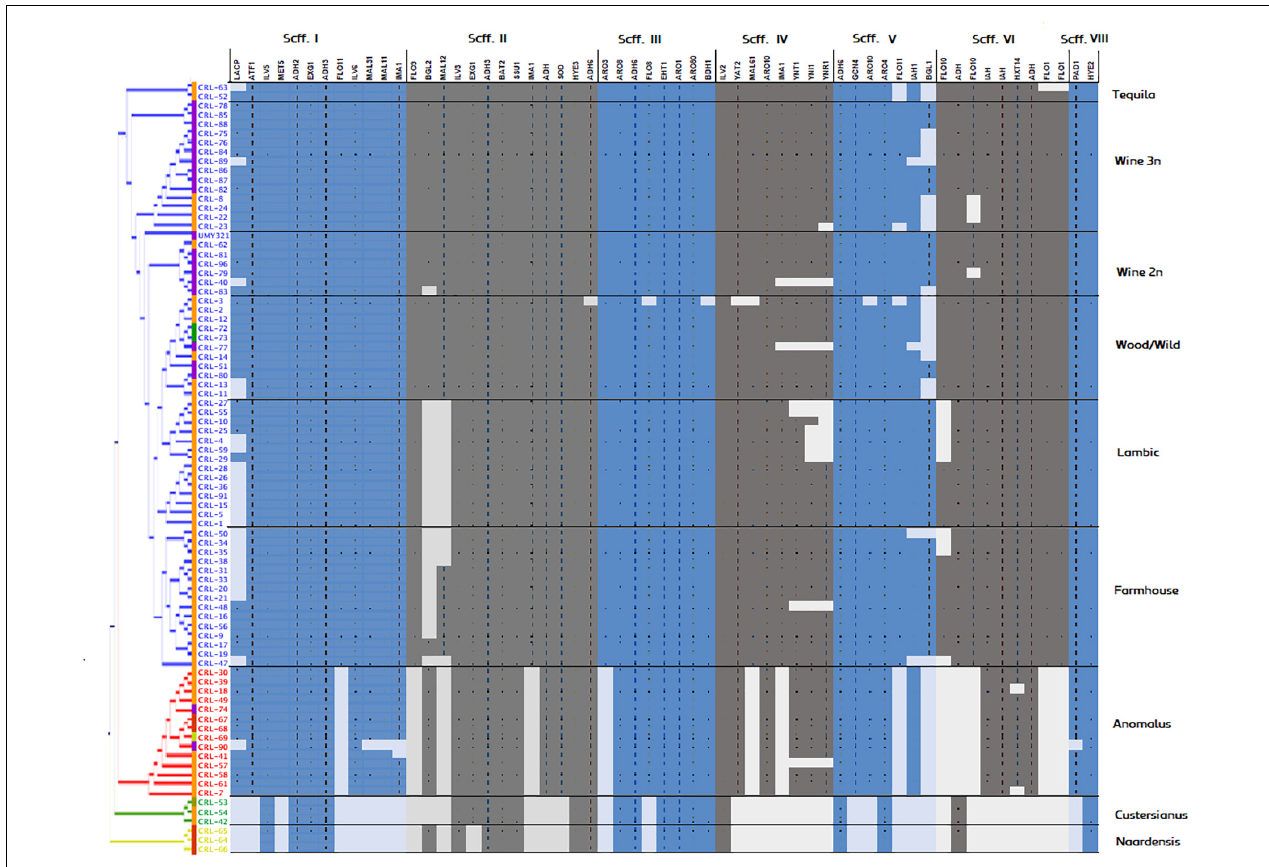
FIGURE 4 | Genomic coverage of Brettanomyces strains included in the study. The reference genes spotted in Figure 3 were subtracted and a BLAST search was performed for each gene, respectively. To predict regions of loss, hits scoring > 95% of the total BLAST score were considered as valid for gene presence. Coloring in the genomic heatmap indicates absence/presence of the respective gene. Two strains showed a low read-mapping coverage and were removed from the figure (CRL-6,